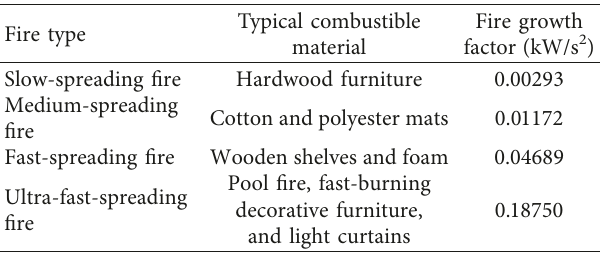
Table 3: Fire growth factors for various